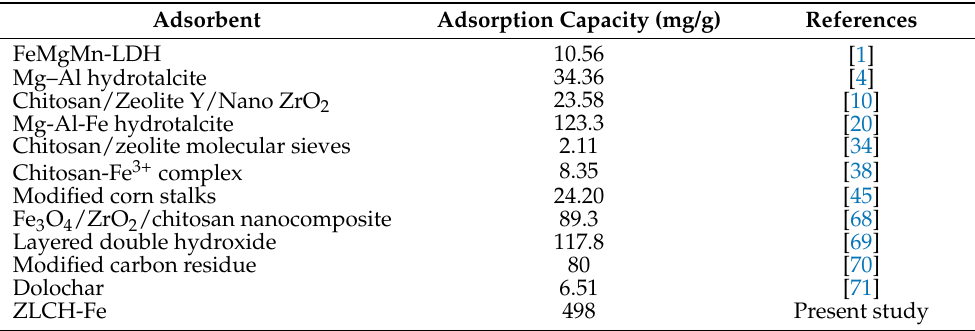
Table 3. Comparison of the nitrate adsorption capacity of several